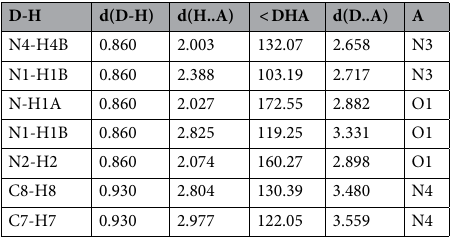
Table 2. Hydrogen bond of the compound 2 .